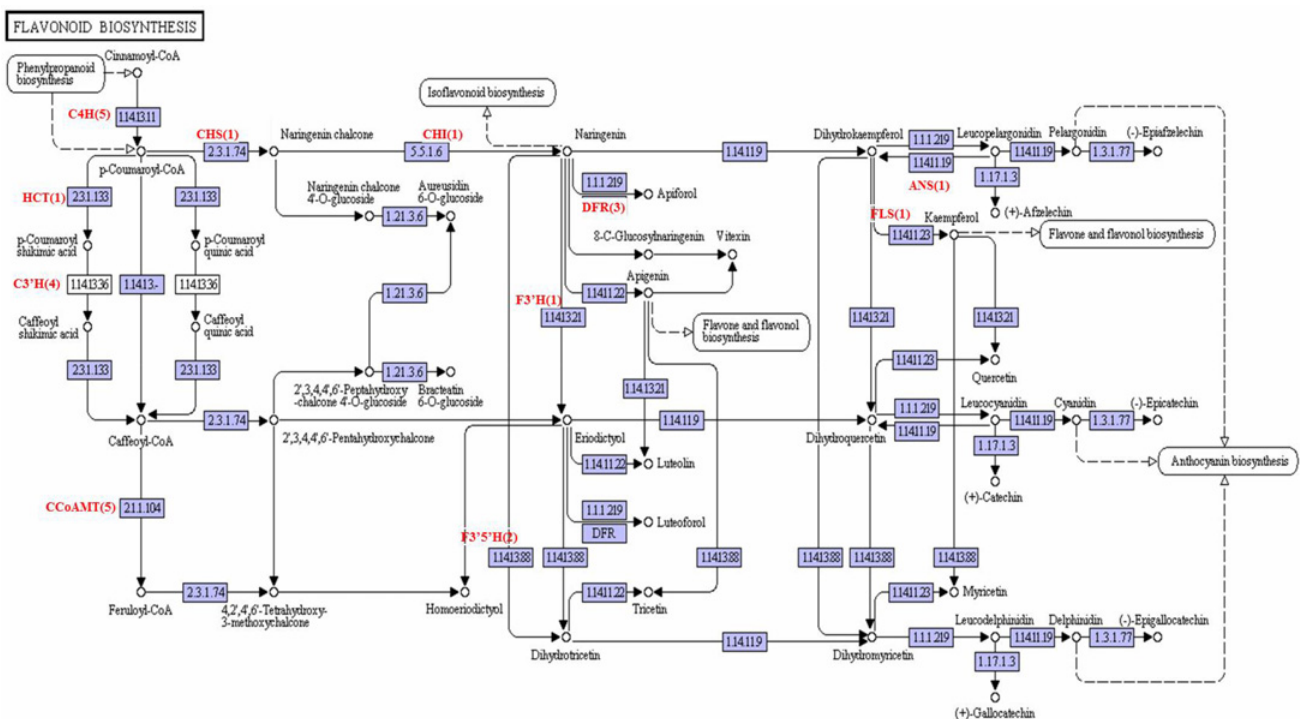
Fig 9. The Flavonoid biosynthesis. The A . comosus var. bracteatus transcripts encoding enzymes (highlighted) involved in the pathway was identified by BLASTx (E-value of less than 10 -5 ). Numbers in bracket are the total number of unigenes encode for the